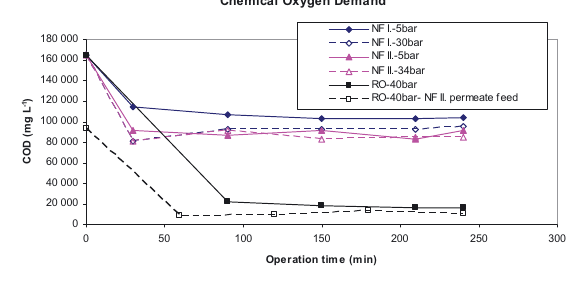
Figure 5. Permeate COD vs. operation time (wastewater of high COD).